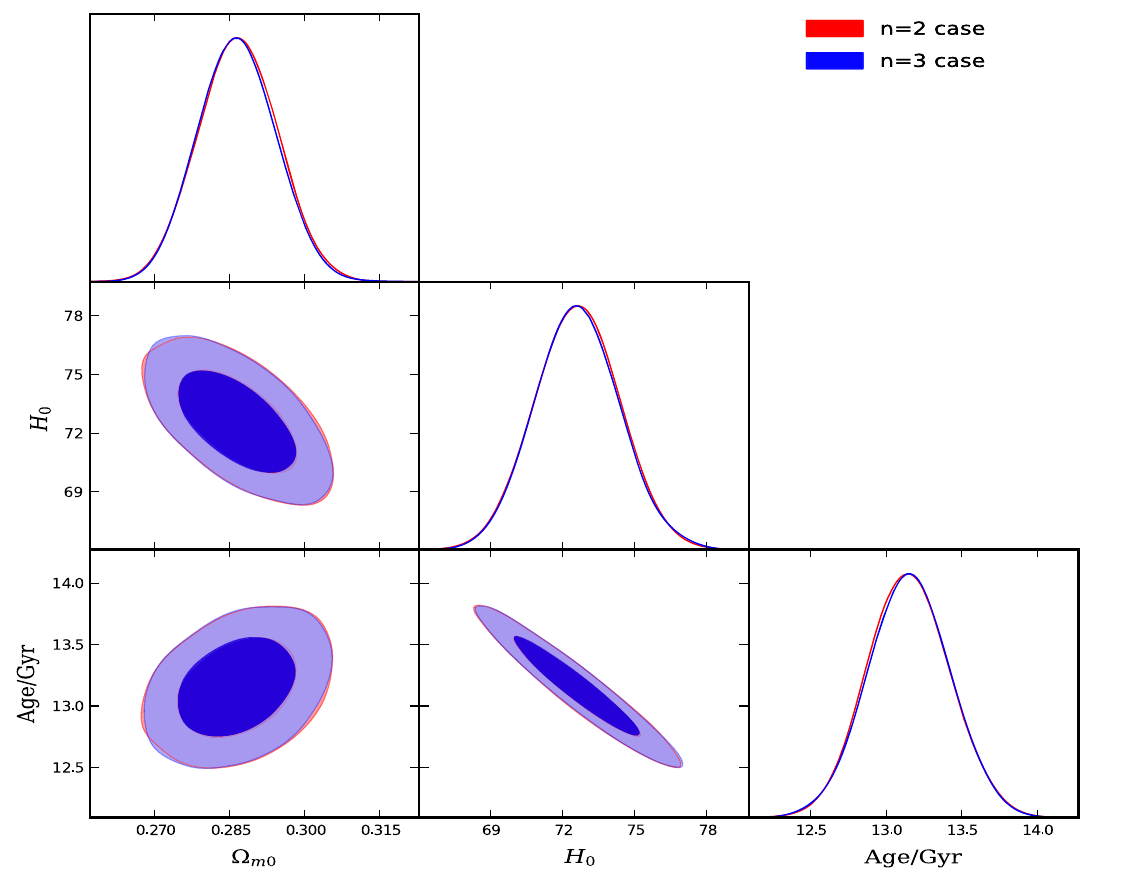
Fig. 5 This figure shows 68% and 95% confidence-level contour plots for the parameters (cid:7) m 0 , H 0 and derived parameter Age as well as their one dimensional marginalized distribution of individual parameters. The figure is displayed for n = 2 and 3 with the combined analysis of BAO, JLA and